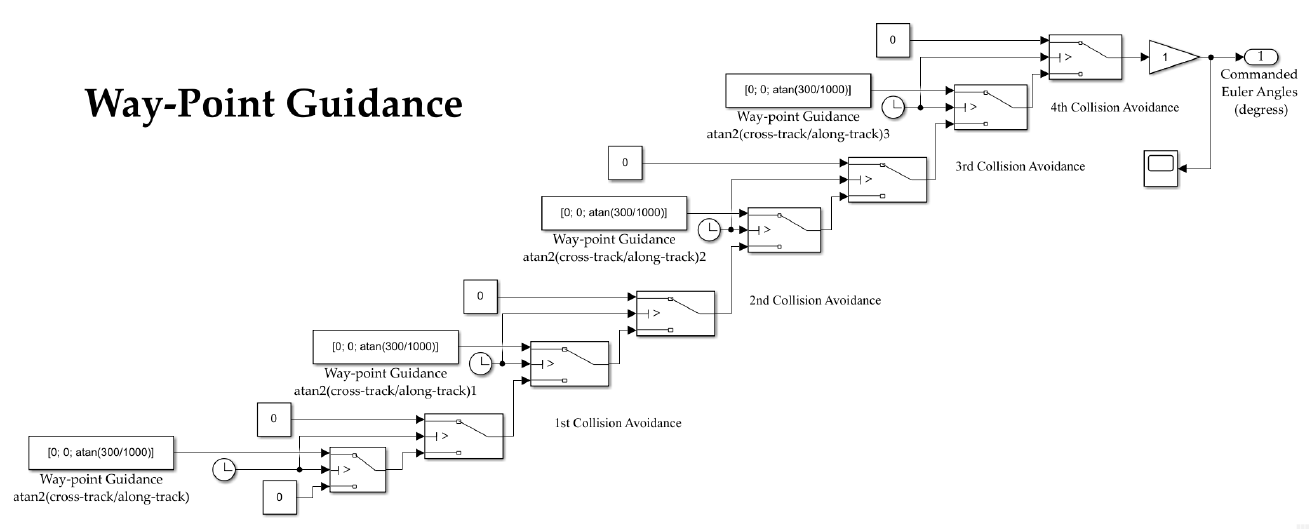
Figure A5. MatLab model with complete detailed display of the way-point guidance Simulink